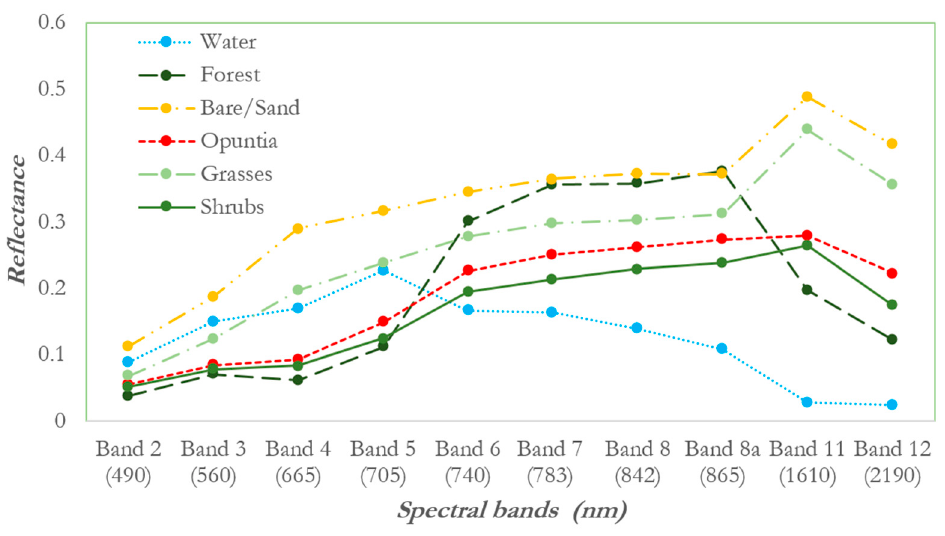
Figure 3. Spectral profile of Opuntia stricta and control classes.